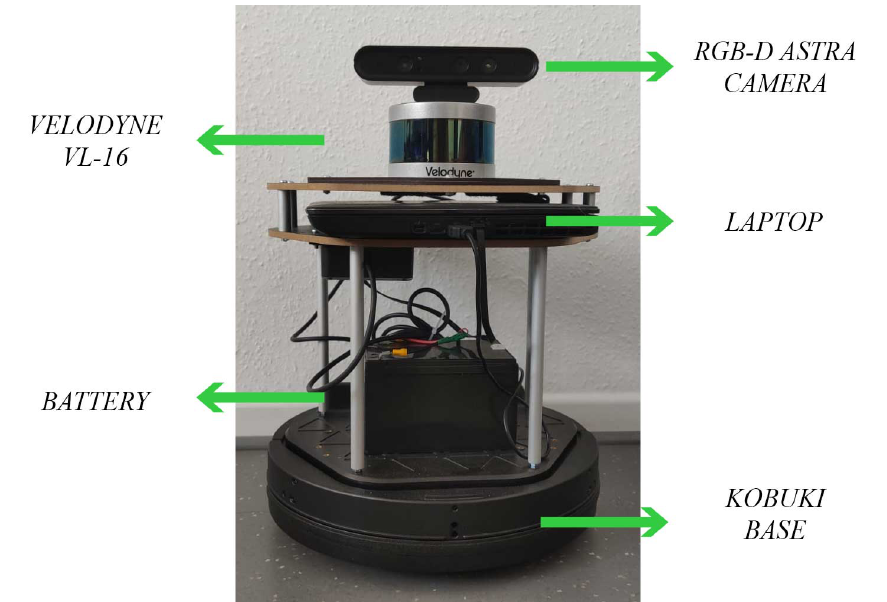
Figure 9. Reference hardware platform based on Turtlebot2 and used for the evaluation of the proposed methods.